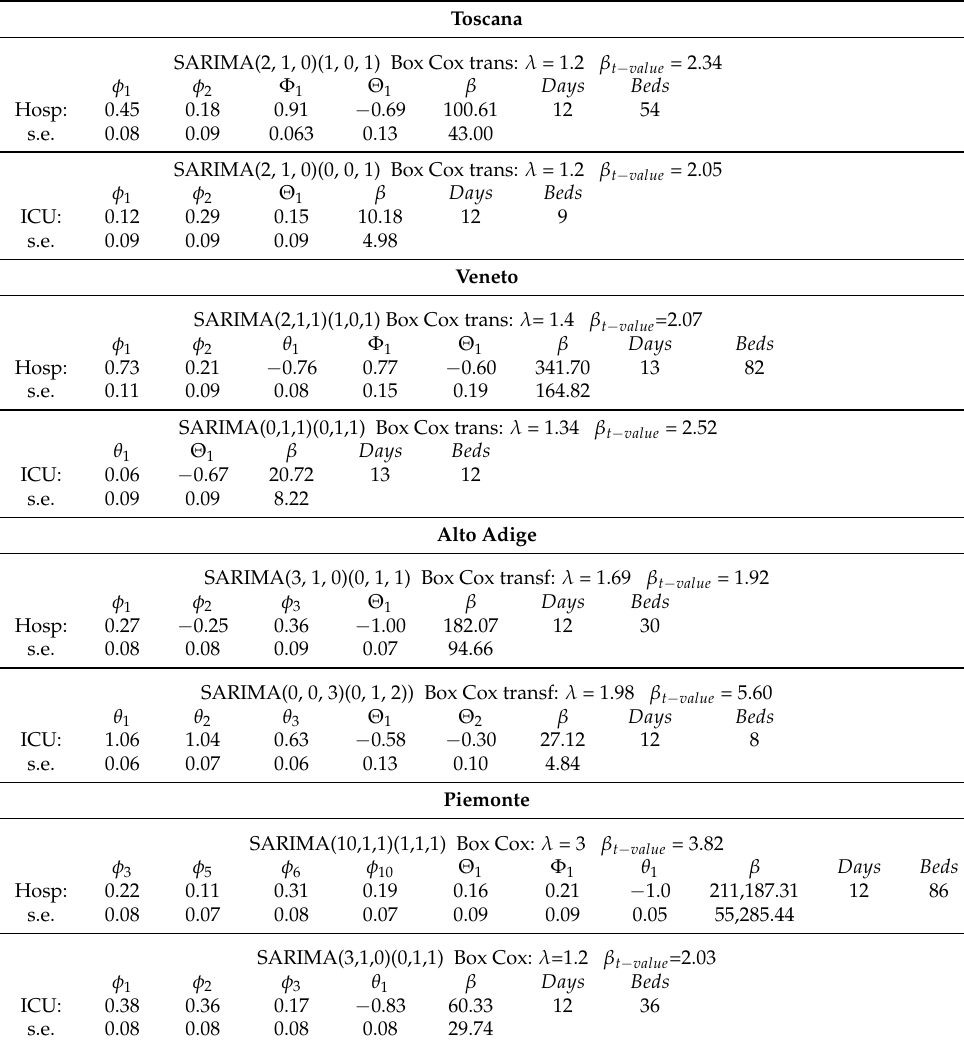
Table 2. This table presents the detailed results of the experiment presented in Section 3.1, for studying the SARIMA lagged correlation between the TPR time series and those of patients admitted in hospitals and ICUs. The last two columns Days and Beds indicate the TPR predictive capacity in days and the number of additional beds in hospital or ICU after 12 days for each TPR